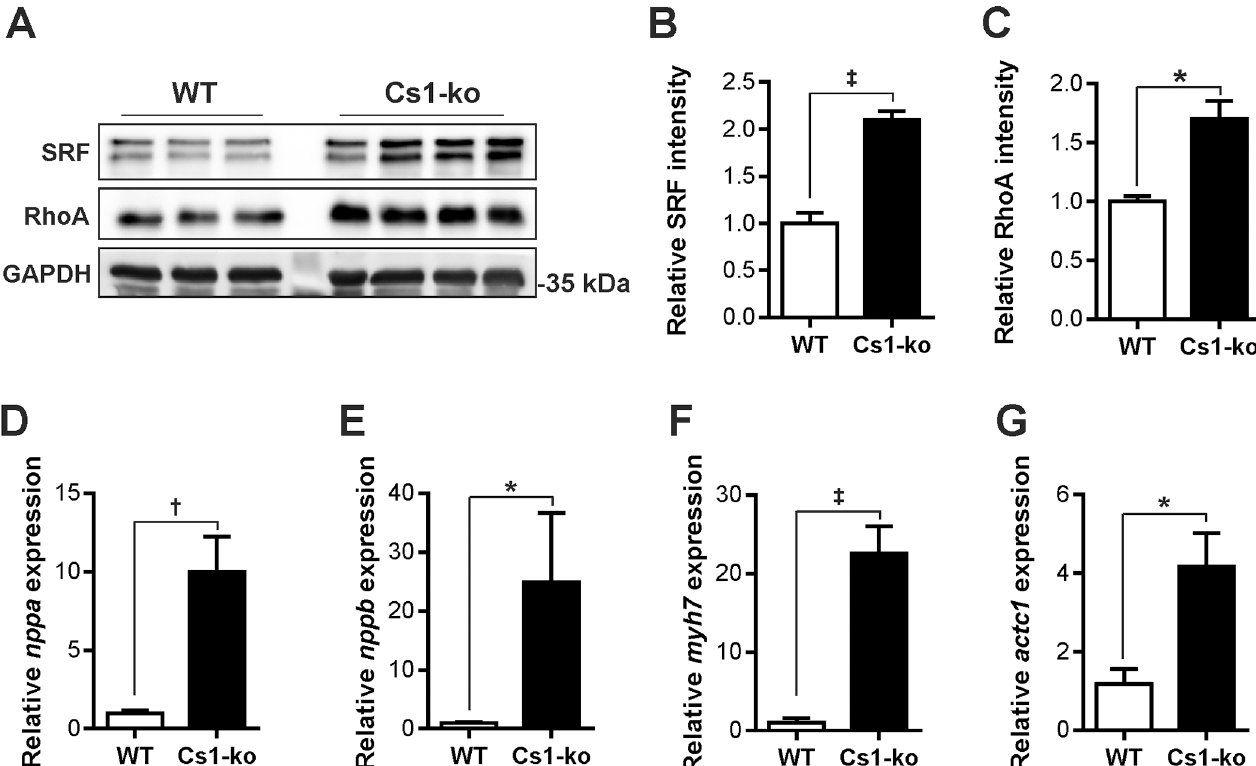
Fig 6. Calsarcin-1deficiency upregulates SRF in mouse heart. ( A ) SRF and RhoA are upregulatedin Cs1-ko mice as depictedin an immunoblot (N = 3 (WT), 4 (Cs1-ko), originaluncroppedblots are shown in S3 Fig, respectivedensitometries are shown as bar graphs in B and C ). Fetal gene program was strikingly activated in Cs1-ko mice as detected by increasedexpressionof nppa ( D ), nppb ( E ), and myh7 ( F ). Similarly cardiac muscle α -actin( actc1 ) was highlyupregulatedin Cs1-ko mice. N = 5 (WT) and 6 (Cs1-ko). The statistical analysiswas carried out using two-tailed student’s t-test . * : p < 0.05,†: p < 0.01,‡: p < 0.001.